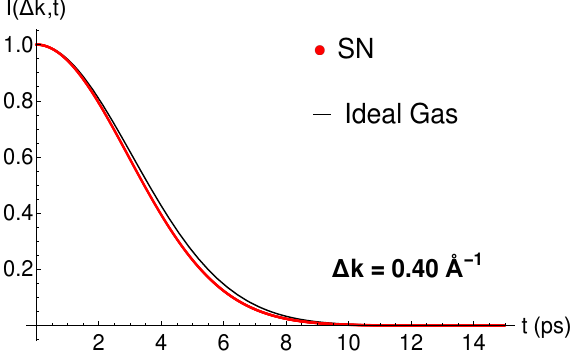
Figure 1. Intermediate scattering function (41) plotted versus the simulation time t ( ps ) for a parallel − 1 wave vector transfer ∆ k = 0.40Å , friction coefficient η = 0, surface temperature T = 105 K and inital adsorbate velocity v 0 = 115 m/s with negative direction. The red curve corresponds to the numerical results of our simulations (SN) and the black curve to the Gaussian function